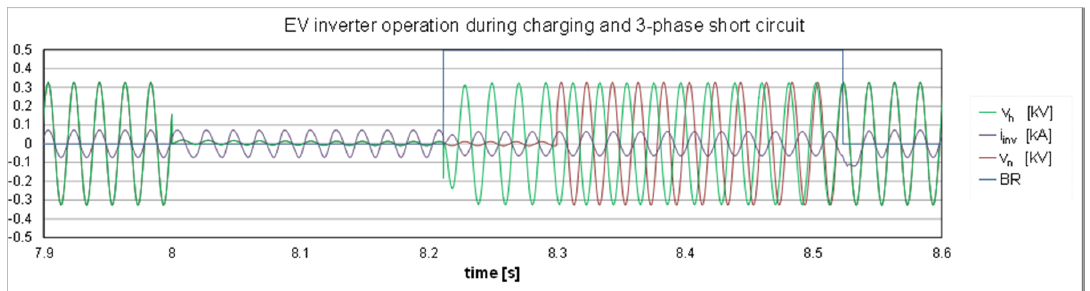
Figure 6. Inverter voltage and current and the network voltage during charging, 3-phase short circuit, island operation and again charging. The BR signal equeal “0” means that BR breaker is closed.